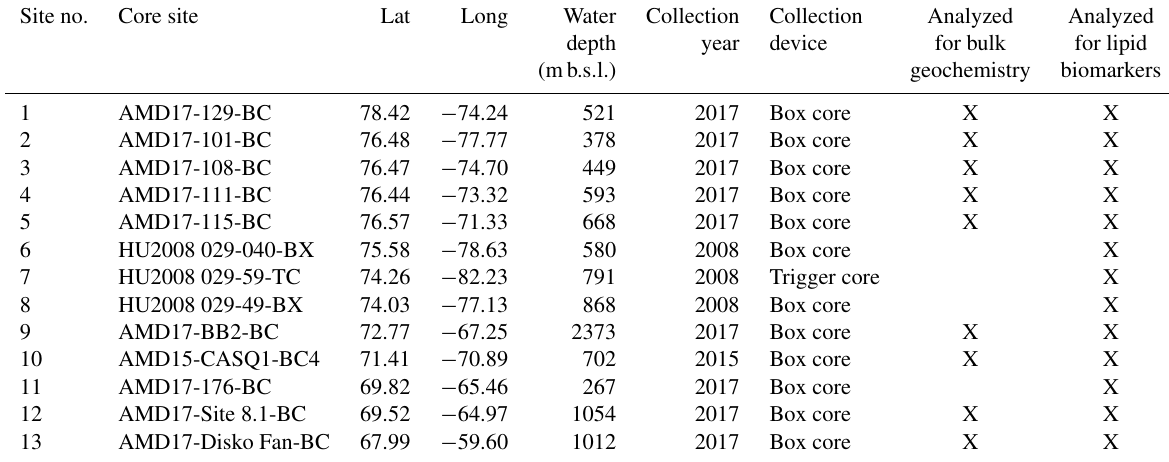
Table 1. Marine surface sediment site information for this study. Site no. Core site Lat Long Water Collection Collection Analyzed Analyzed depth year device for bulk for lipid (mb.s.l.) geochemistry biomarkers